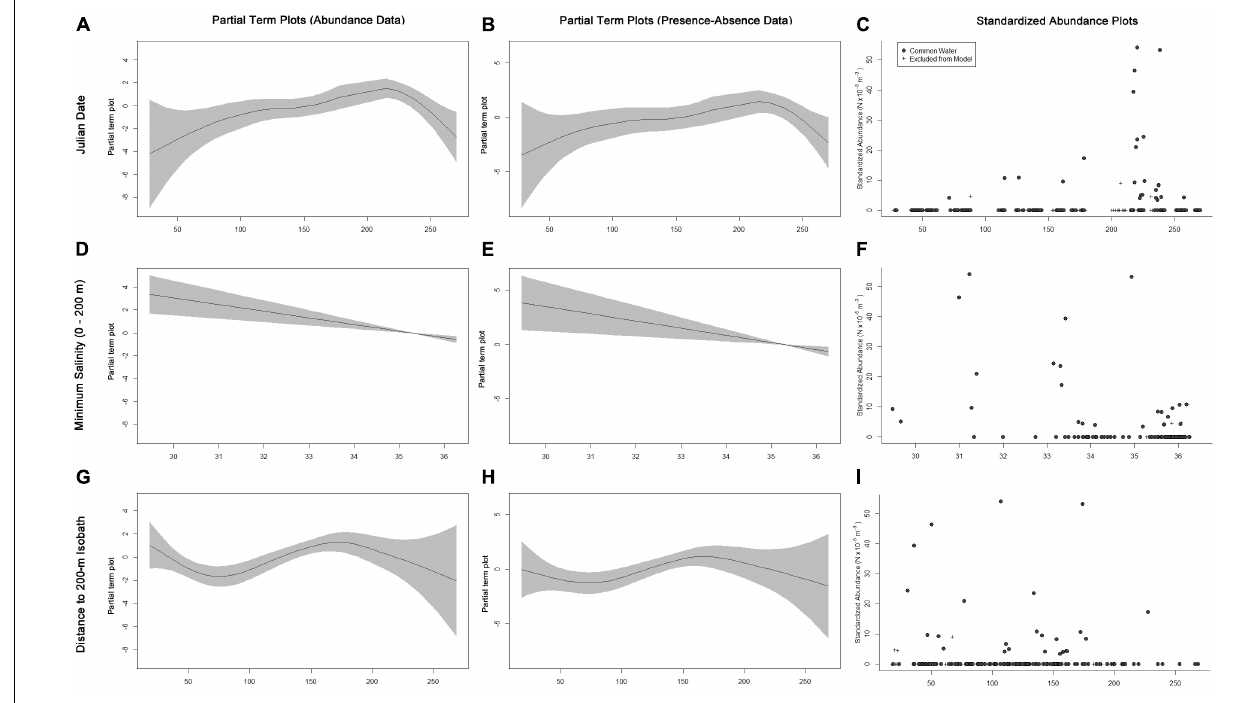
FIGURE 3 | Term plots for the best-fitting models for Euthynnus alletteratus data fitted to the abundance data (A,D,G) and presence–absence data (B,E,H) . Standardized abundance plots (C,F,I) are also presented for all important and marginally important variables. Data that had to be excluded from the model due to missing MOCNESS sensor data are indicated by